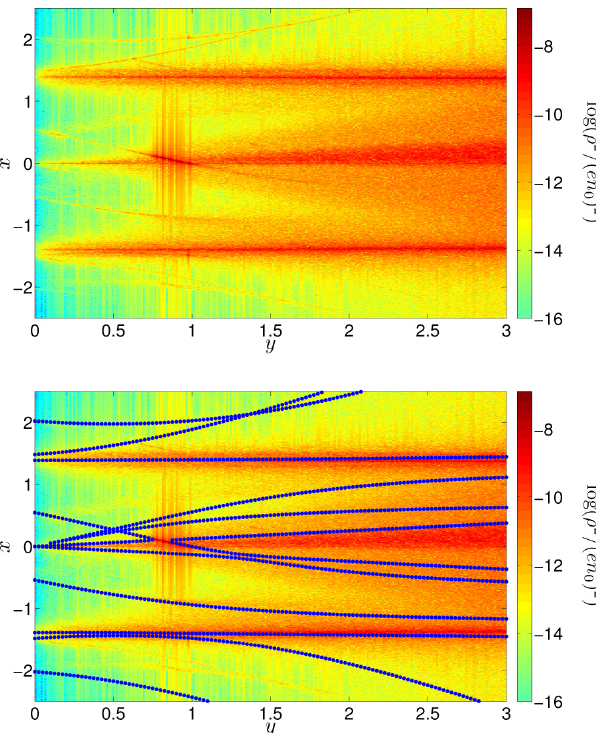
Fig. 20. Power spectrum of density fluctuations for the PIC simula- tion. The pump wave satisfies Eq. (21), with α = 0 . 2 and µ = 100, and is taken from the Alfvén branch, with y 0 = 0 . 49, x 0 = 0 . 27. (a) Simulation results; (b) lines correspond to the fluid dispersion relation of the parametric decays, Eq. (57), for the same parame- ters. Fig. 21. Growth rate for the decay instability shown in Fig. 20.